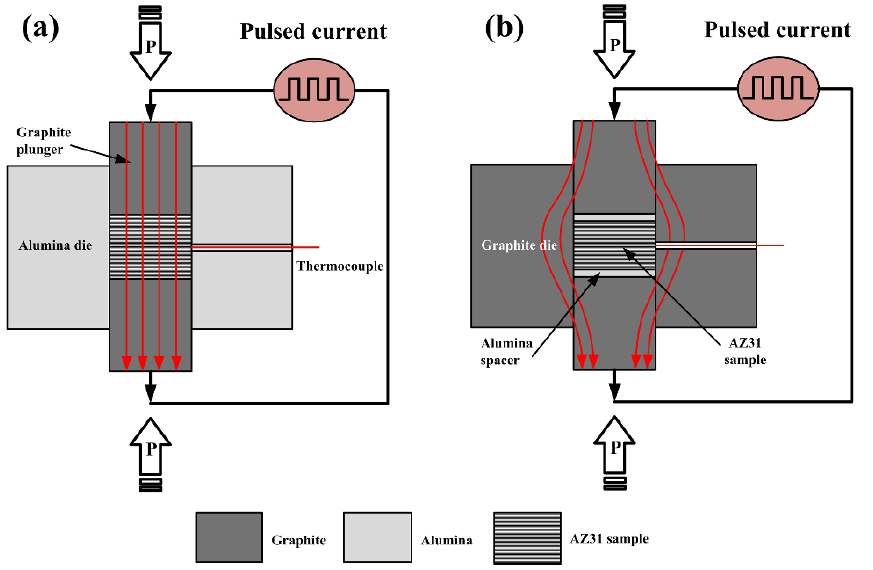
Figure 1. Schematic representation of the ensemble configurations: ( a ) current-assisted mode; ( b ) current-insulated mode.